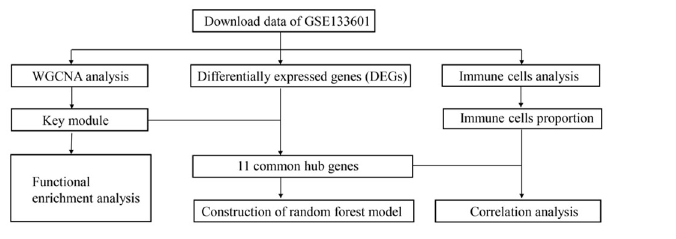
Fig 1. Flow chart for the whole